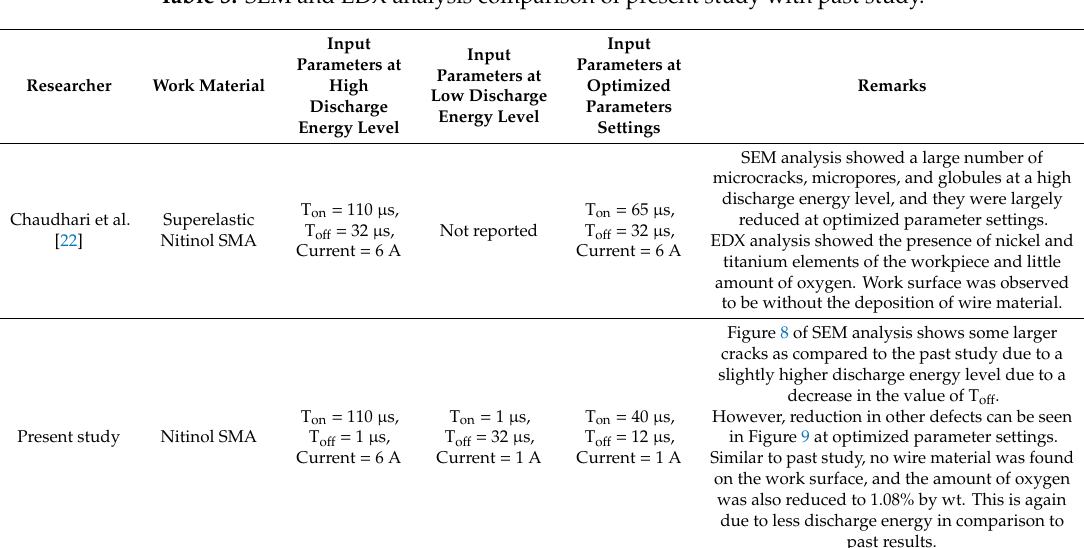
Figure 9. SEM micrograph at optimized parameter settings. Table 3. SEM and EDX analysis comparison of present study with past